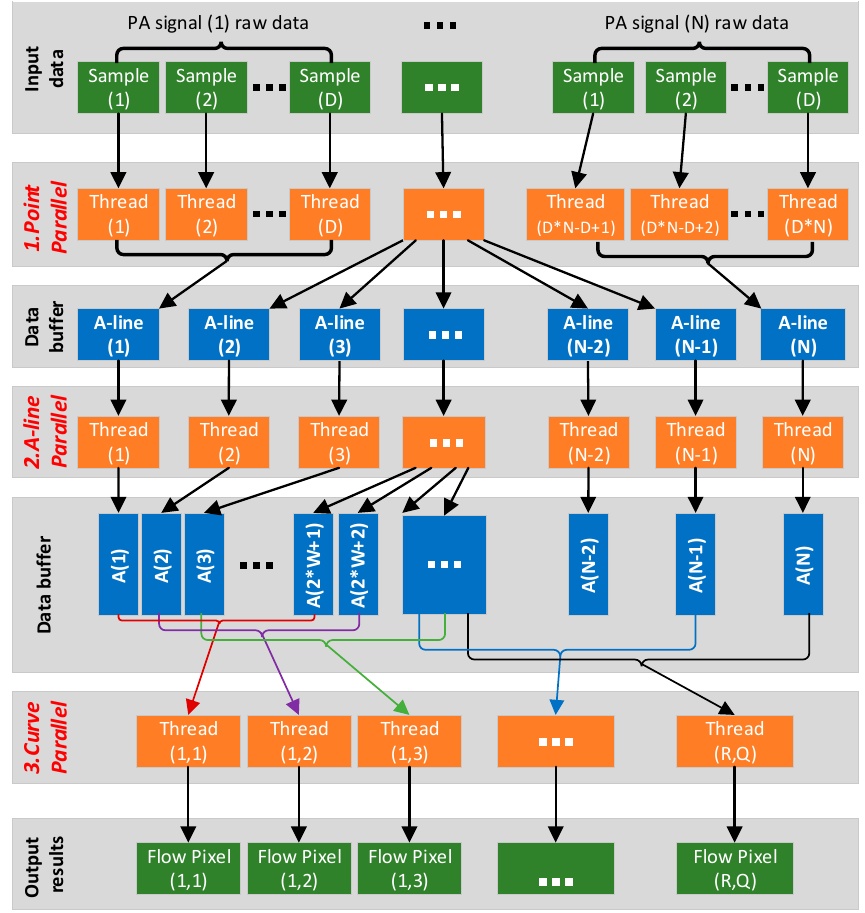
Figure 5. Structure design of p a rallel computing for the algorithm .